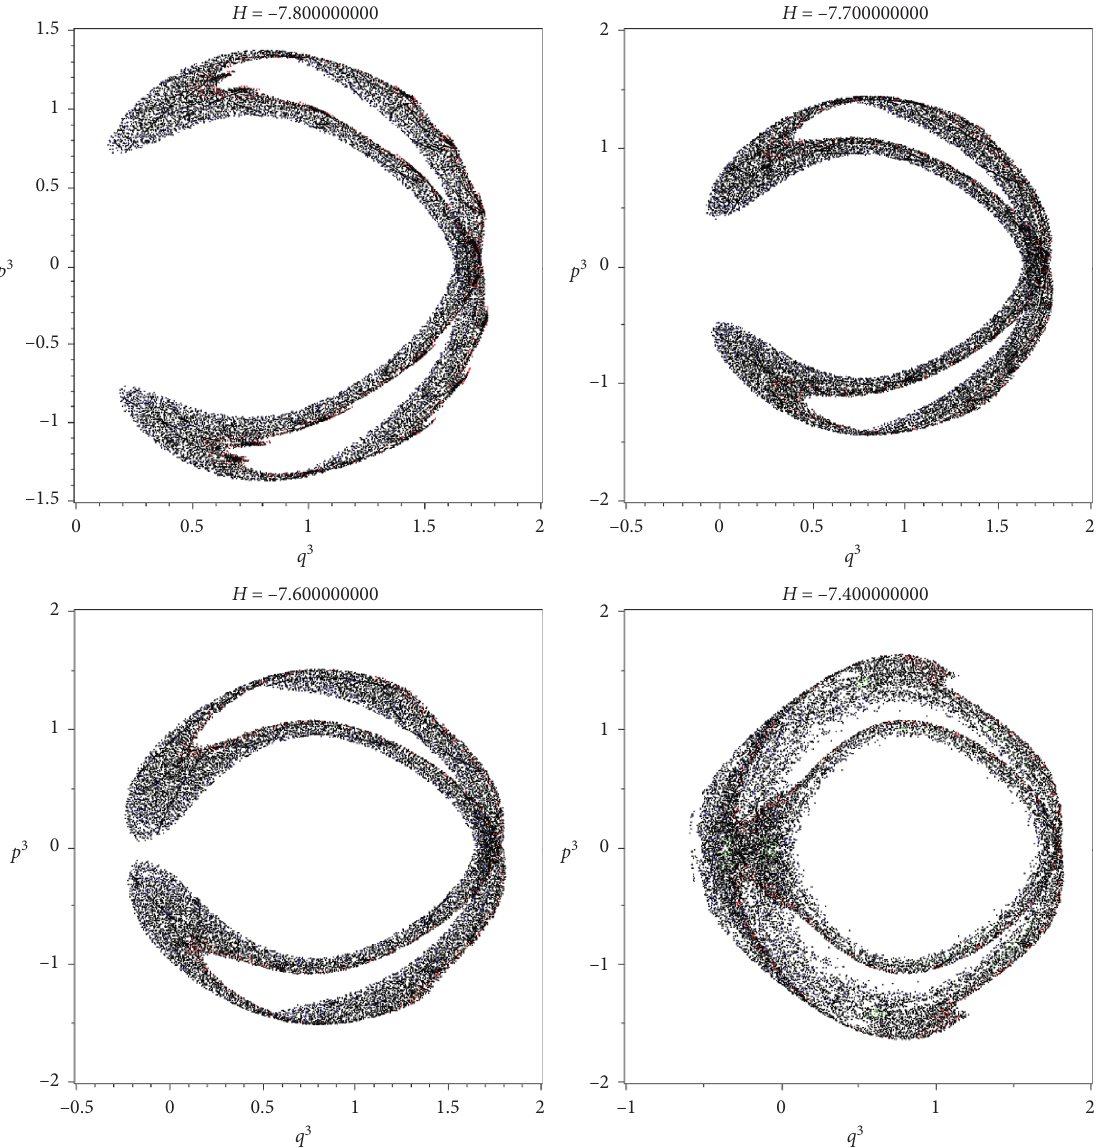
Figure 13: The progressive changing of a Poincar ´ e surface of sections for different energy levels in the unequal masses case ( m � 1 . 03, m � m � 1, b � 1 . 9, and c � 0 . m 2 3 1